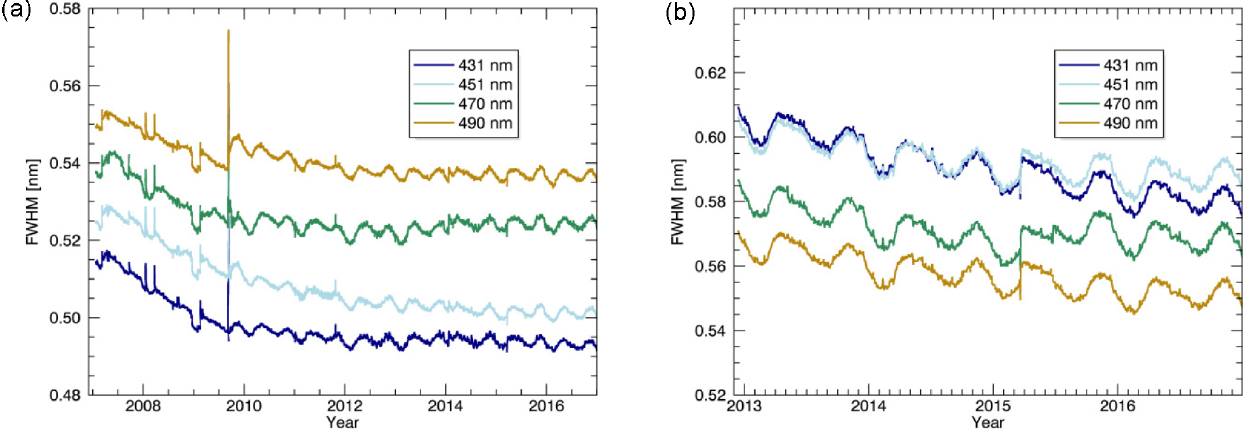
Figure 2. Temporal evolution of the fitted slit function FWHM for GOME-2A ( a , January 2007–December 2016) and GOME-2B ( b ,